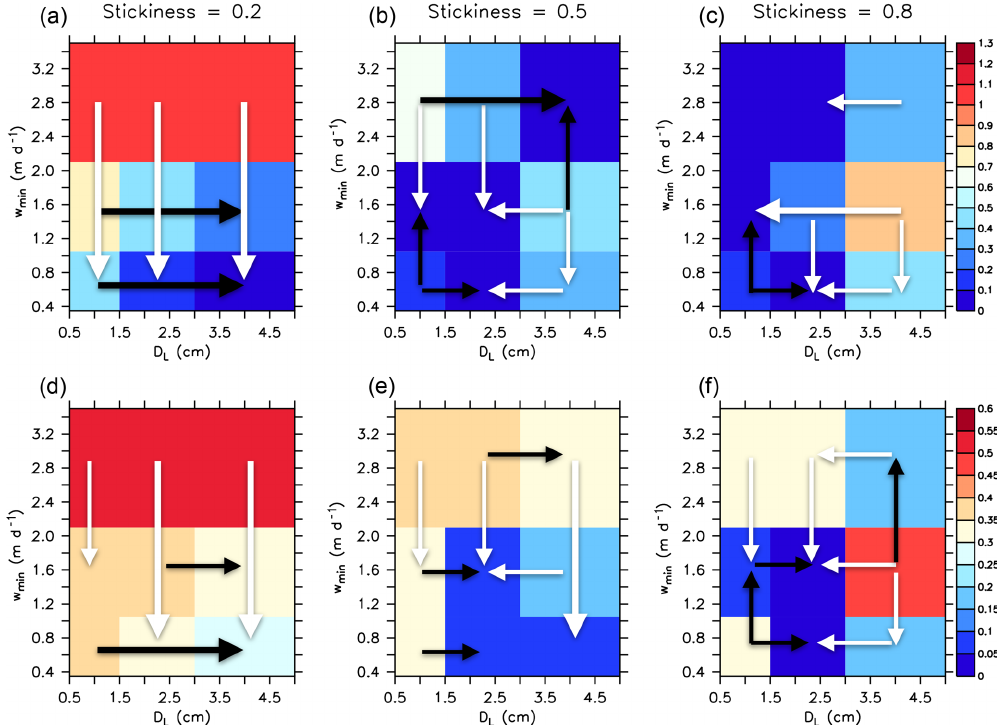
Figure 6. As Fig. 5 but for simulations with ECCO1.0.